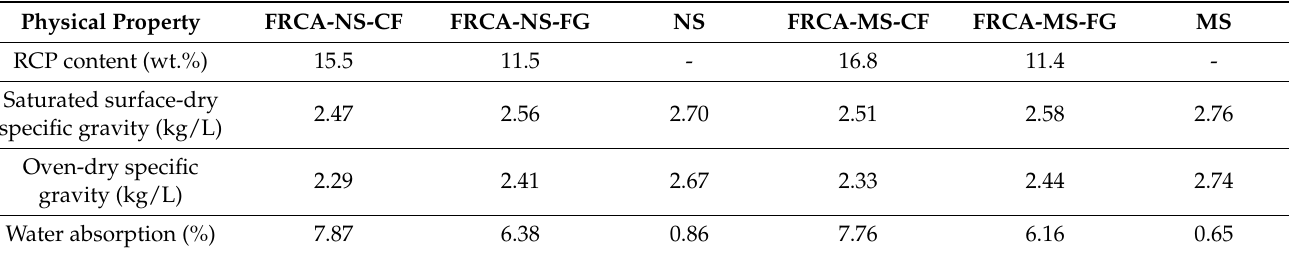
Table 2. Properties of FRCA and natural aggregates.